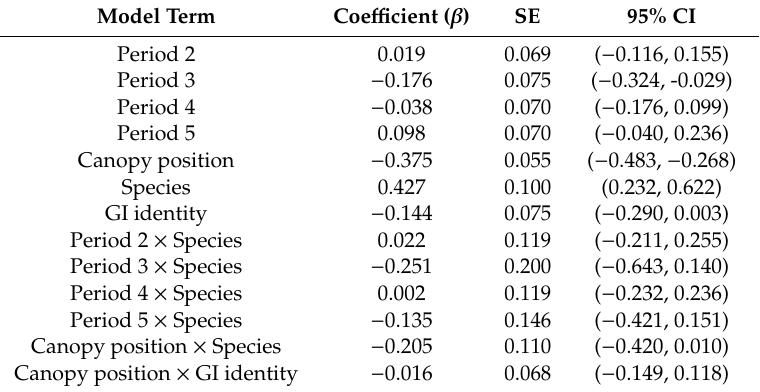
(cid:12) (cid:12) (cid:12) (cid:12) (cid:12) β (cid:12) > 0.1). Only terms in models with a